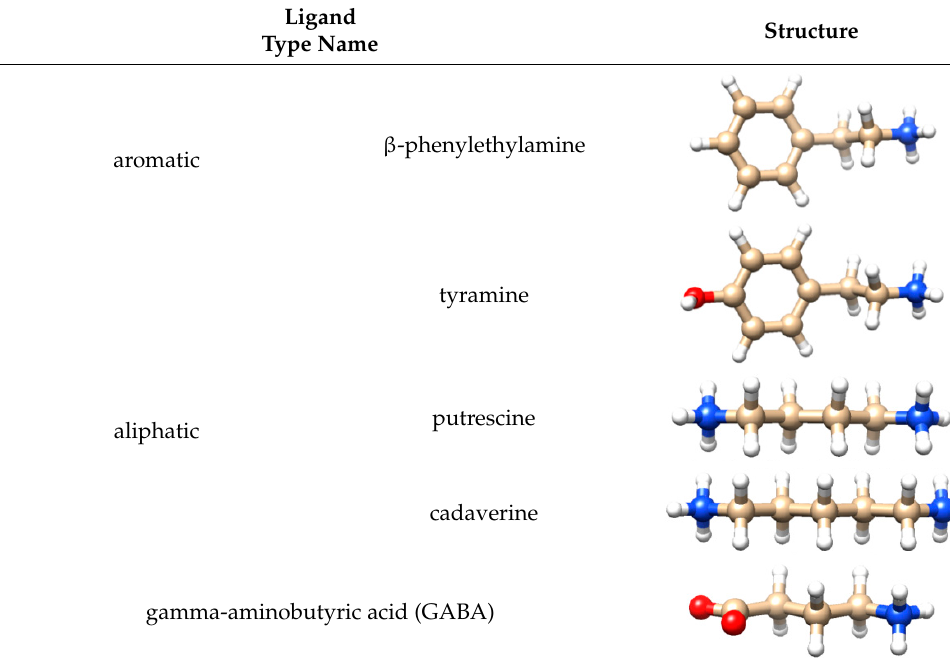
Table 8. Calculation options for the human TAAR1 and TAAR6 receptor models with Asp amino acid residues included in the binding pocket.